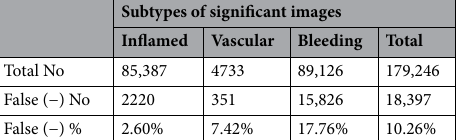
Table 6. False negative rate by the CNN model according to subtypes of significant